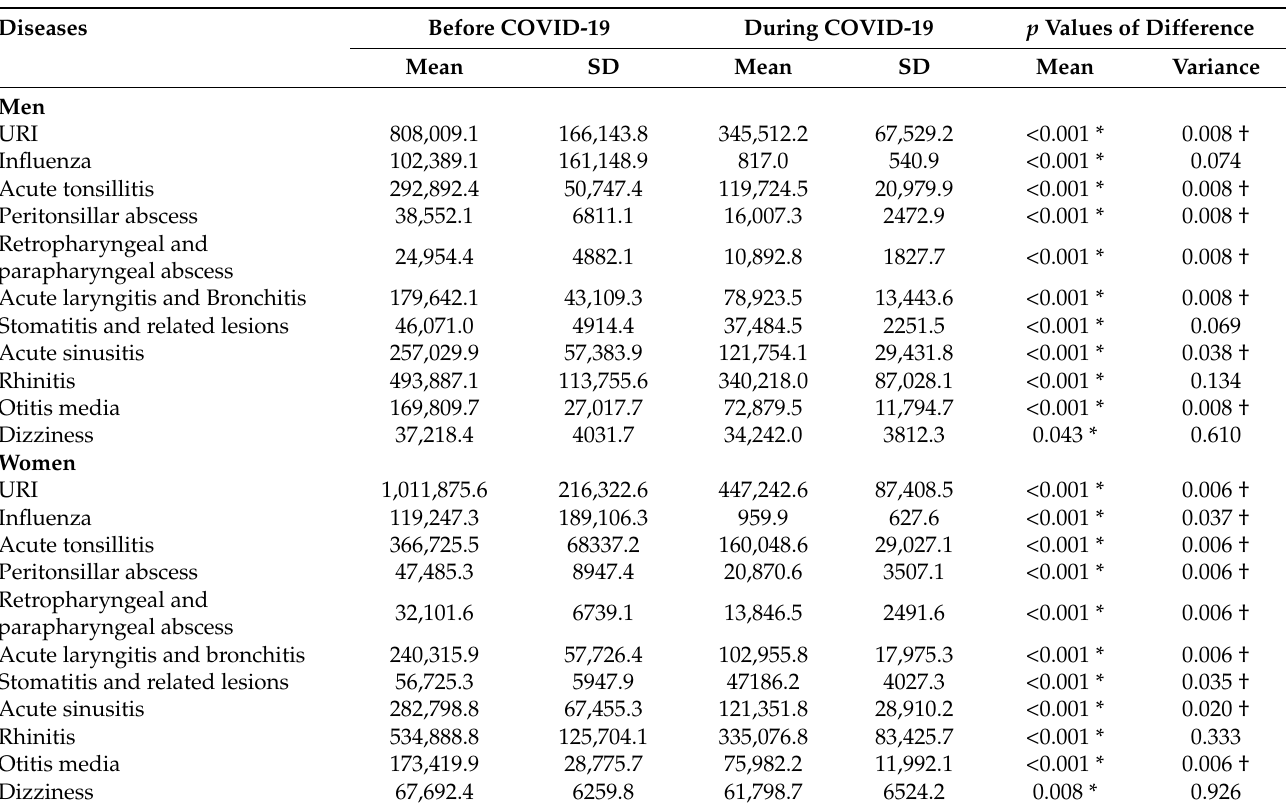
Table 2. Mean and standard deviation of the incidence of diseases before and during COVID-19 and their differences in the subgroups relative to sex.